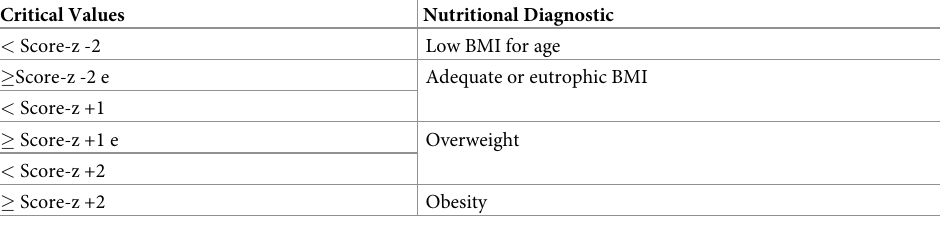
Table 1. BMI cutoff points for children over 5 years of